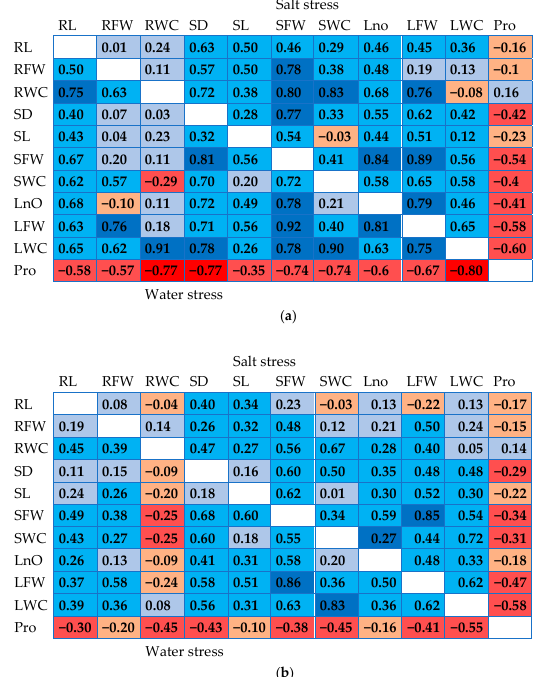
Figure 1. Heatmap of Pearson moment correlation coefficients (r) between the analysed traits in Phaseolus vulgaris cultivars submitted to two weeks ( a ) and three weeks ( b ) of water and salt stresses. Dark blue denotes high correlation ( r → 1), dark red high negative correlation ( r → − 1). Abbreviations: RL, root length; RFW, root fresh weight; RWC, root water content; SD, stem diameter; SL, stem length; SFW, stem fresh weight; SWC, stem water content; Lno, leaf number; LFW, leaf fresh weight; LWC, leaf water content; Pro, proline content.